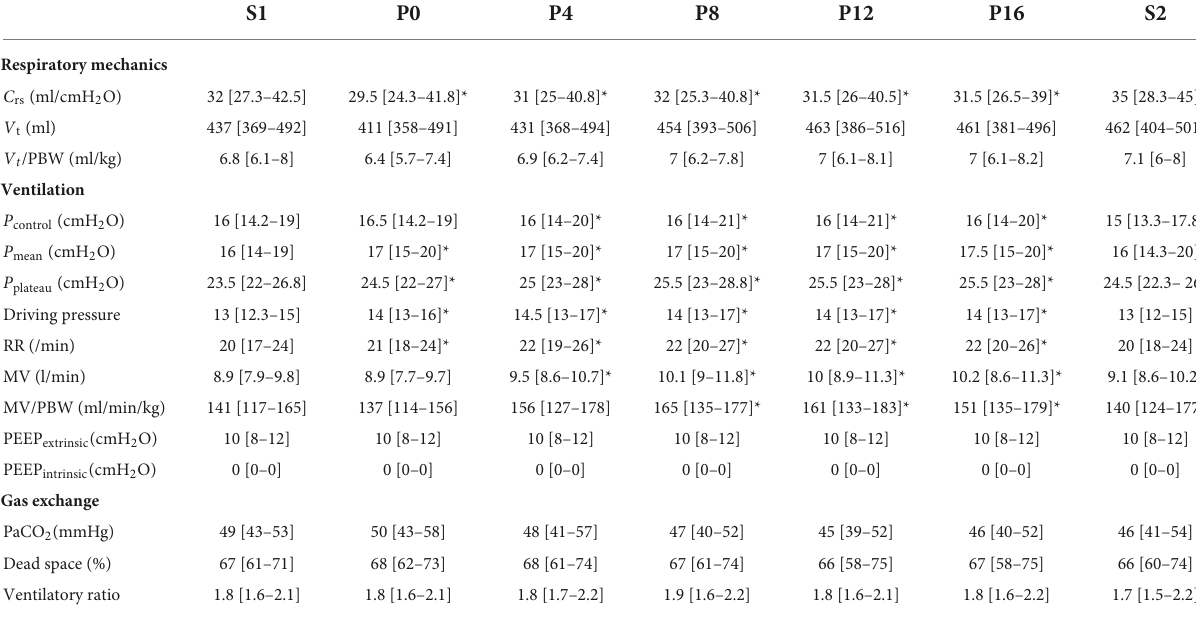
TABLE 3 Respiratory mechanics, gas exchange and ventilatory settings over